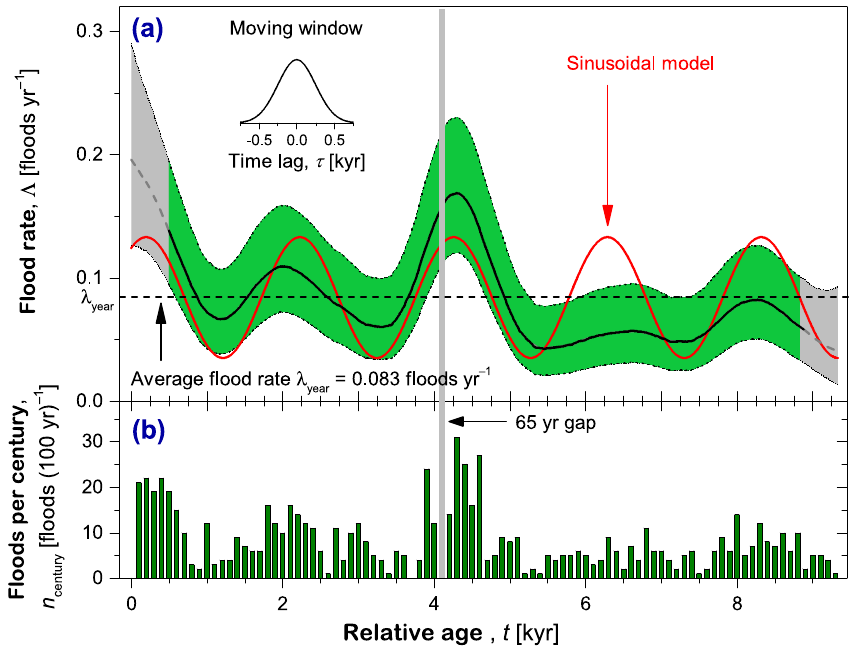
Figure 11. Analysis of flood rate fluctuations. (a) Shown is the time-dependent flood rate (cid:51) (black line) and its 95% confidence bands (green bands) as a function of the relative age t = 1 to 9336 years for the palaeoflood data set shown in Fig. 3 which was computed by using a kernel density estimator. The grey colour indicates results that might be affected by boundary effects. The estimator is based on a Gaussian kernel with a width of ± 3 σ , where σ = 250 years (Appendix C), shown in the inset figure. Also shown are the average flood rate (dashed grey horizontal line) of λ year = 0 . 83 floods yr − 1 and the best-fit sinusoidal curve (red curved line, Eq. 16). (b) For a comparison, the number of floods per century n century (green bars) is presented. The grey vertical bar indicates the gap in the data